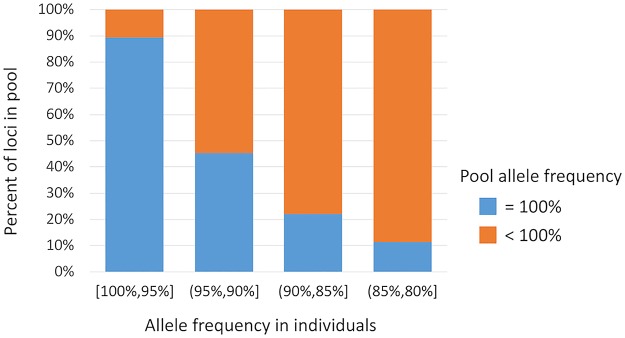
Allele dropout in pool-seq.Loci were binned according to allele frequency in individual samples, and then categorized by whether the allele frequency from pool-seq was 100% (blue) or not (orange). That is, blue indicates allele dropout where the minor allele was not detected by pool-seq.